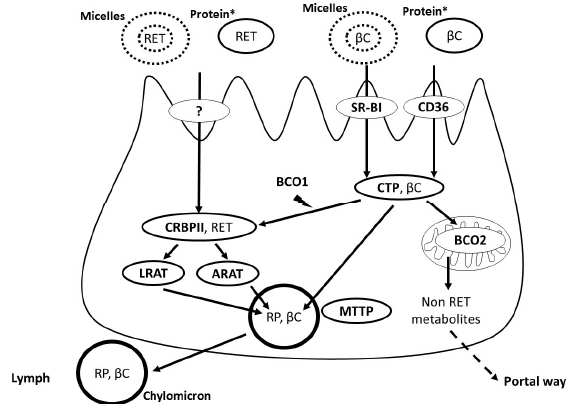
Figure 2. Proteins involved in vitamin A metabolism within the enterocyte. ARAT: acyl-CoA:retinol acyltransferases; β C: β -carotene and all other provitamin A carotenoids; BCO1: β -carotene oxygenase 1; BCO2: β -carotene oxygenase 2; CD36: cluster determinant 36; CRBPII: cellular retinol binding protein II; CTP: cellular transport protein (BCO1 and L-FABP are candidates); LRAT: lecithin